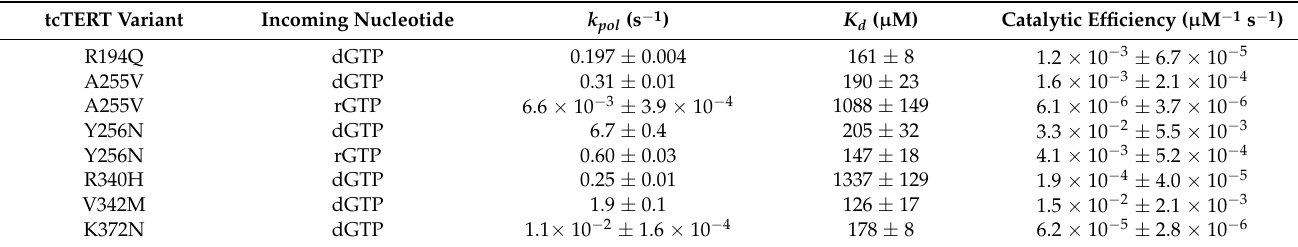
Table 2. Summary of Kinetic